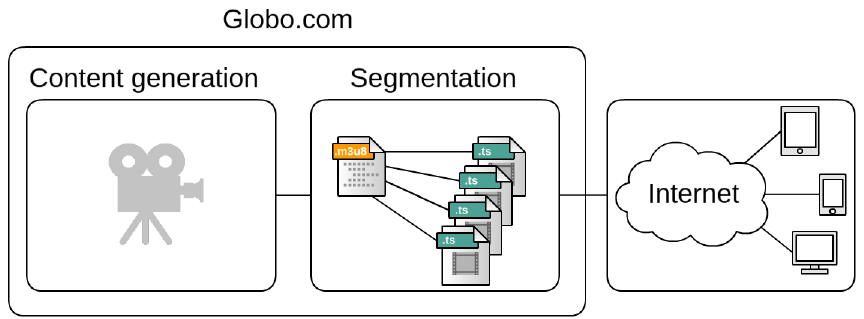
Figure 1. Globo.com